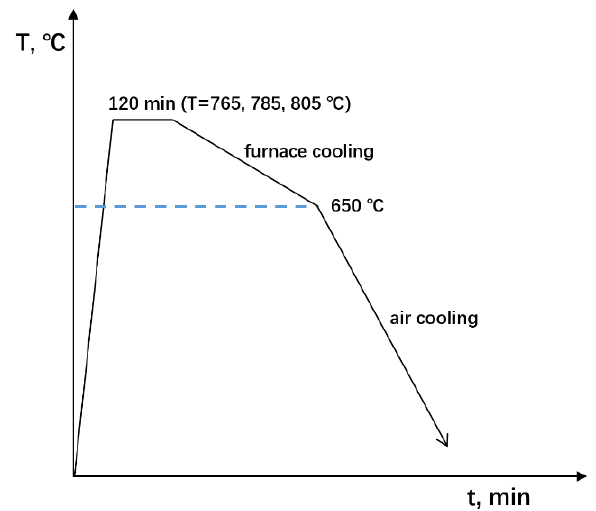
Figure 1. Schematic annealing procedure diagram.